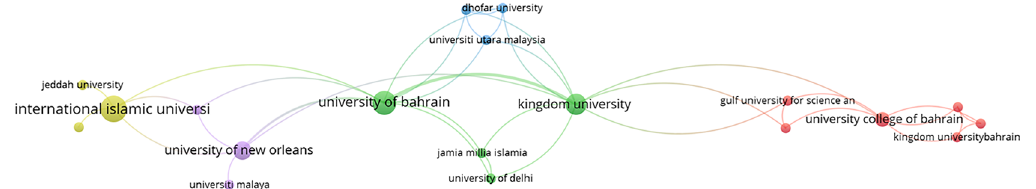
Figure 7. The collaboration network of